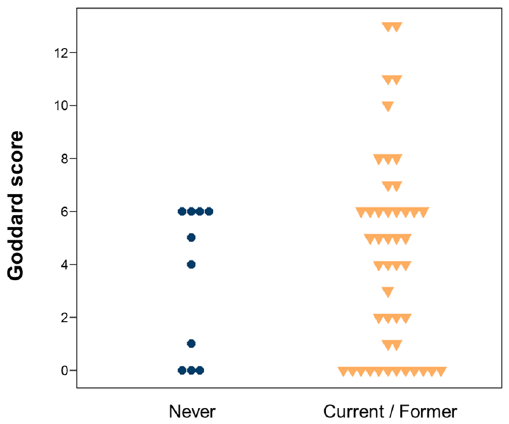
Figure 1. Relationship between smoking history and Goddard score.